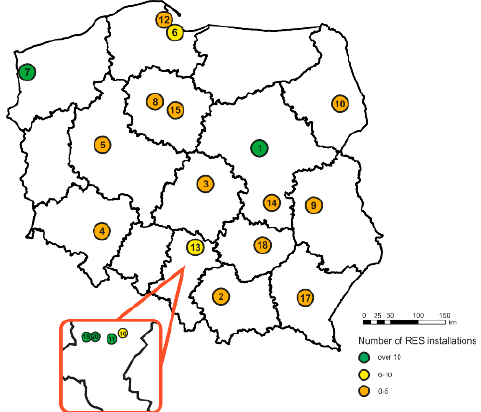
Figure 3. RES installations in cities in Poland. Explanations: 1 Warsaw, 2 Kraków, 3 Ł ód ź , 4 Wroc ł aw,